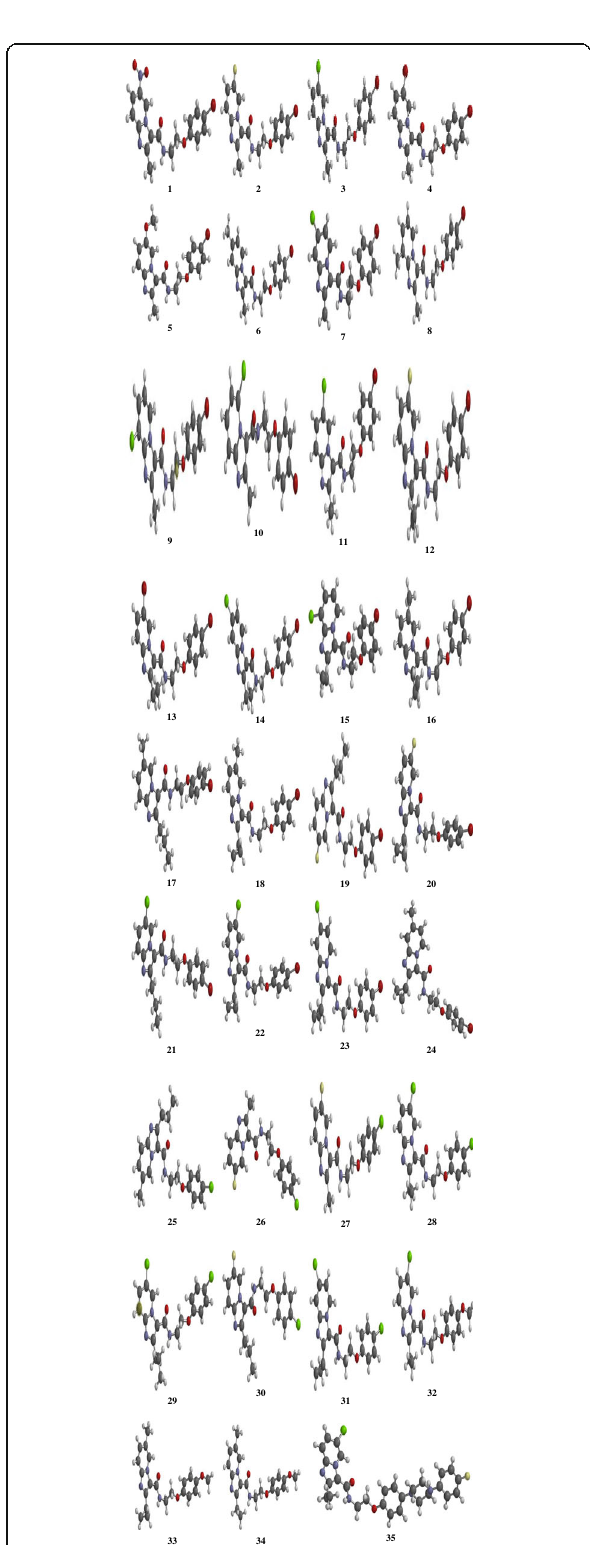
Fig. 2 DFT-optimized chemical structures of the imidazo[1, 2-a] pyridine-3-carboxamides